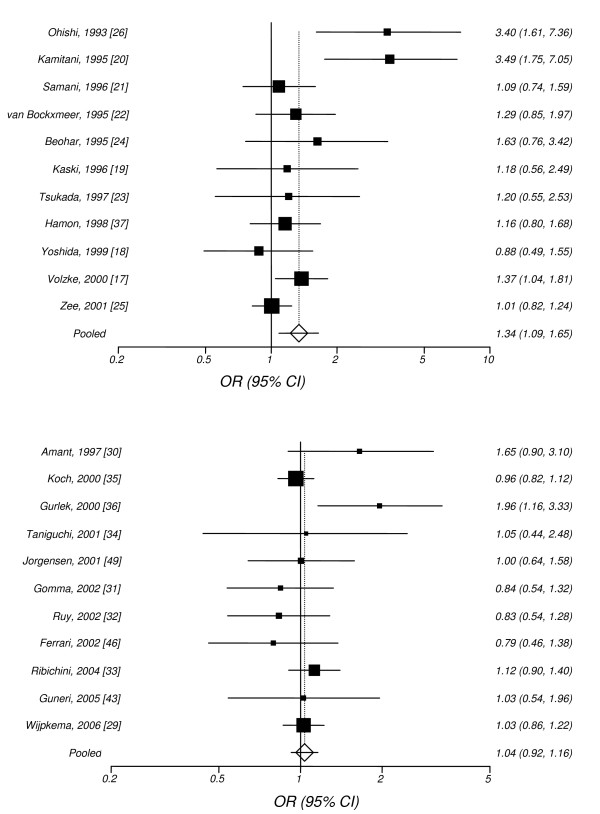
Random effects (RE) odds ratio (OR) estimates with the corresponding 95% confidence interval (CI) of the allele contrast (ACE D vs. I) for restenosis a) after PTCA-balloon, and b) after PTCA-STENT. The OR estimate of each study is marked with a solid black square. The size of the square represents the weight that the corresponding study exerts in the meta-analysis. The confidence intervals of pooled estimates are displayed as a horizontal line through the diamond. The horizontal axis is plotted on a log scale.